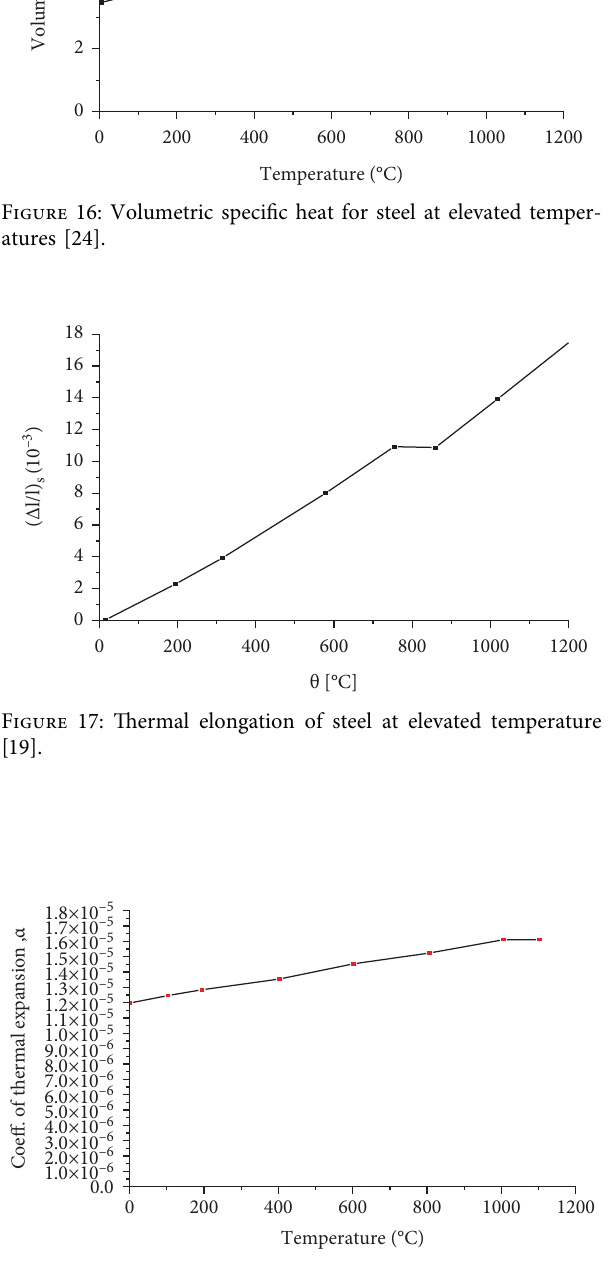
Figure 18: Variation of secant thermal expansion coefcient with temperature